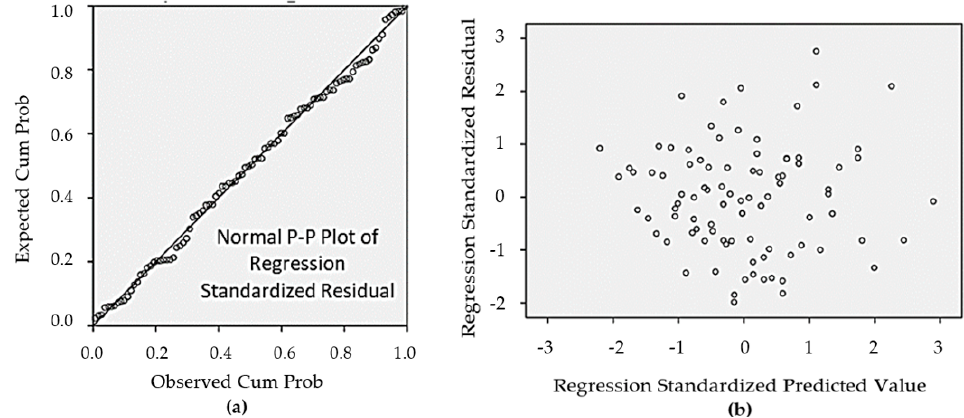
Figure 2. Normal distribution and homoscedastic behavior of the residuals via ( a ) a normal P-P plot of regression and ( b ) a scatter plot.